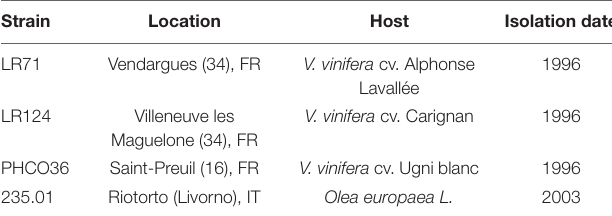
TABLE 1 | Fomitiporia mediterranea strains used in laboratory experiments in this